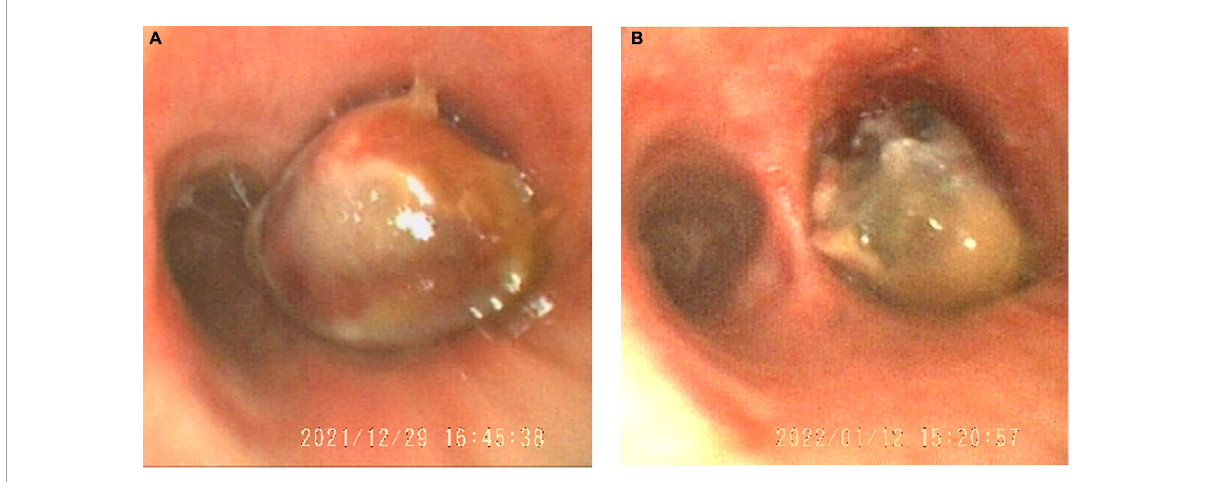
FIGURE2 The tumor in the trachea obstructed the main right bronchial opening viewed in the bronchoscope (A) . After vascular thrombosis therapy, the tumor reduced (B) .